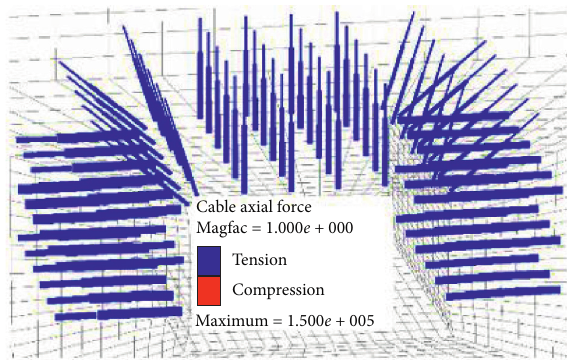
Figure 8: Distribution diagram of axial force of roadway bolt.